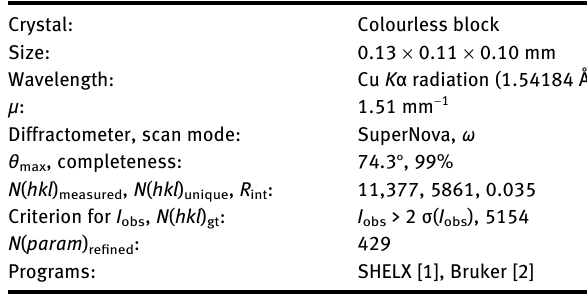
Table  : Data collection and